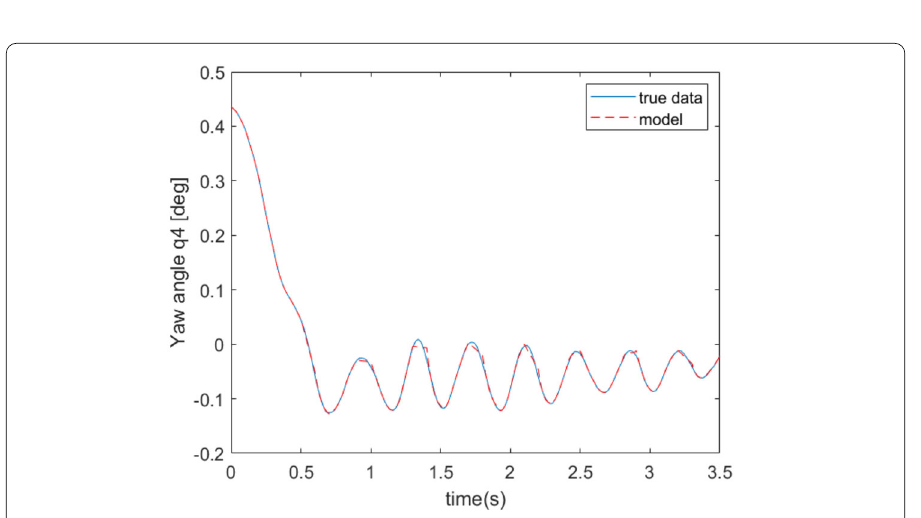
Figure 17 Model match between the identified nonlinear model against the measured yaw angle